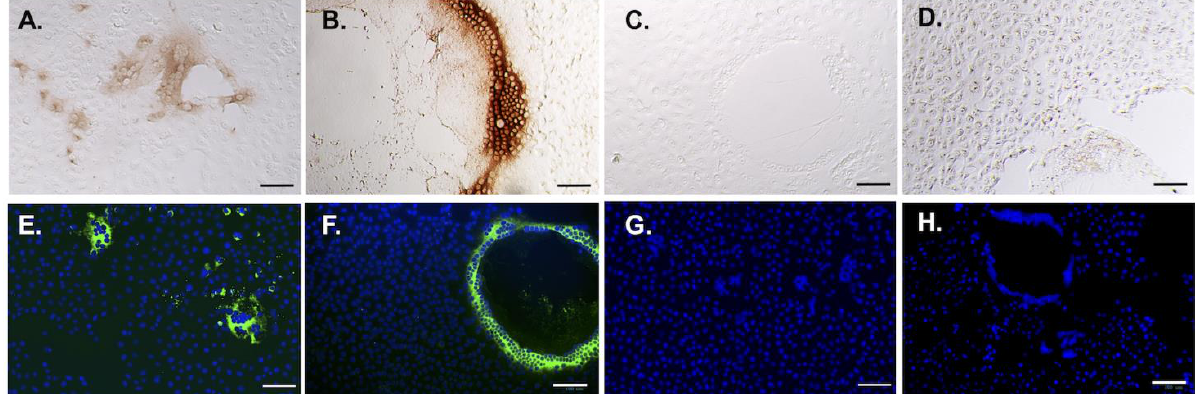
Figure 3. ICC and IFA of scFv against PEDV-infected cells. The purified scFv was used as the primary antibody to stain PEDV-PT (G2 PEDV) and CV777(G1 PEDV). The DAB coloration substrate was added for visualization in ICC ( A – D ); DAPI was used to stain the nuclei in IFA ( E – H ). ( A , E ) The immunostainings of scFv against PEDV-PT-infected cells. ( B , F ). The immunostainings of scFv against CV777-infected cells. ( C , G ). The controls of immunostainings of PEDV-PT-infected cells. ( D , H ) The controls of immunostainings of CV777-infected cells. The bars represented 100 μm in length.